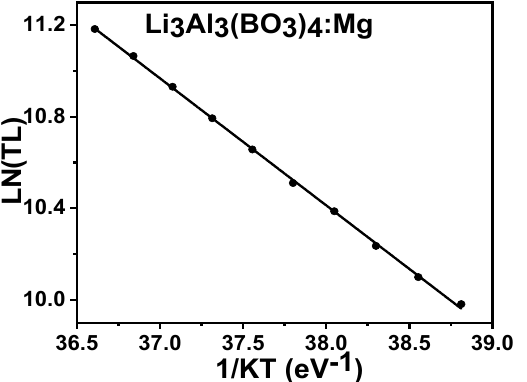
Figure 10. The plots of LN(TL) versus 1/kT for Mg ‐ doped lithium aluminium